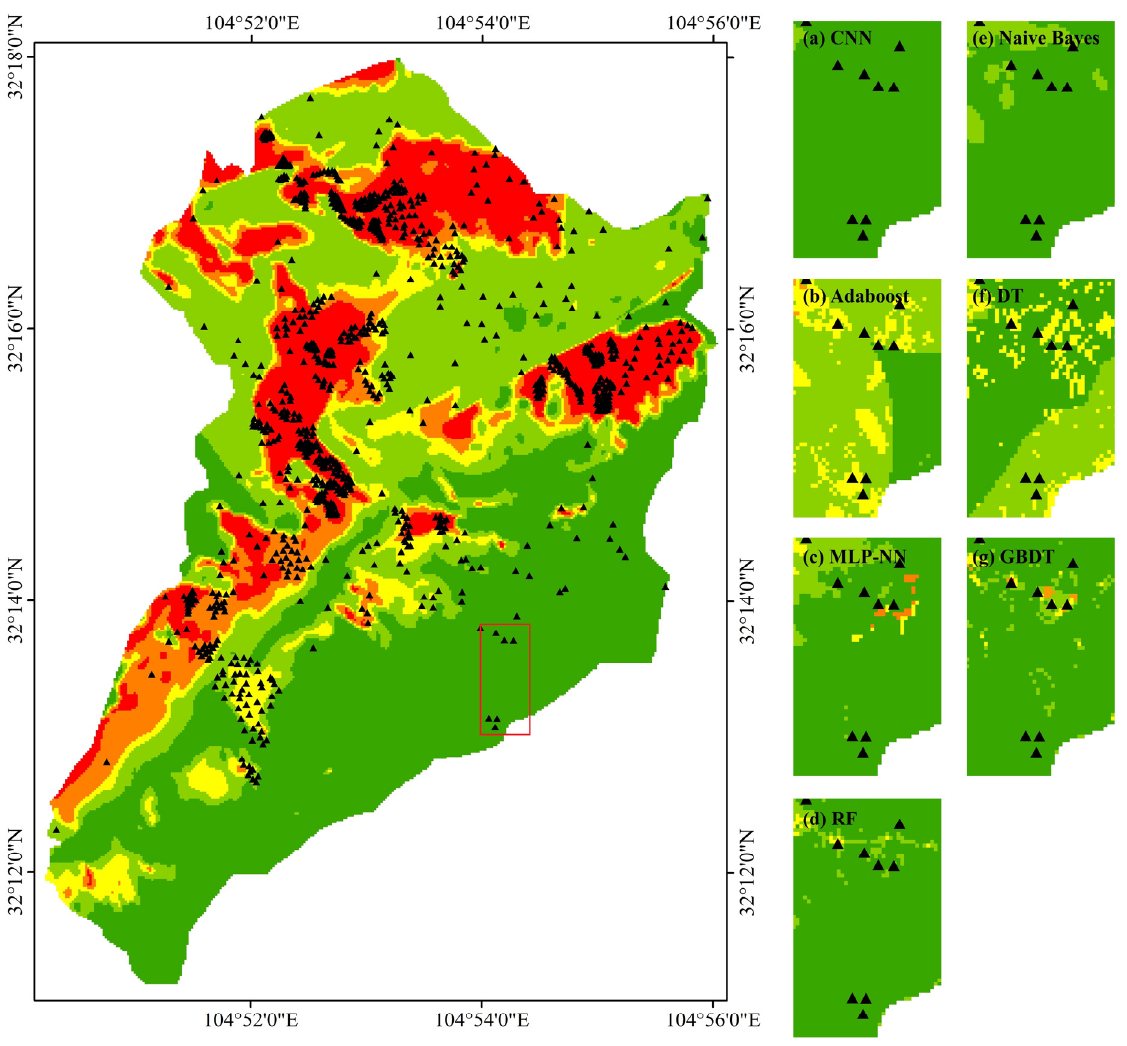
Figure 9. CNN and six ML susceptibility maps in the southeastern part of the study area.